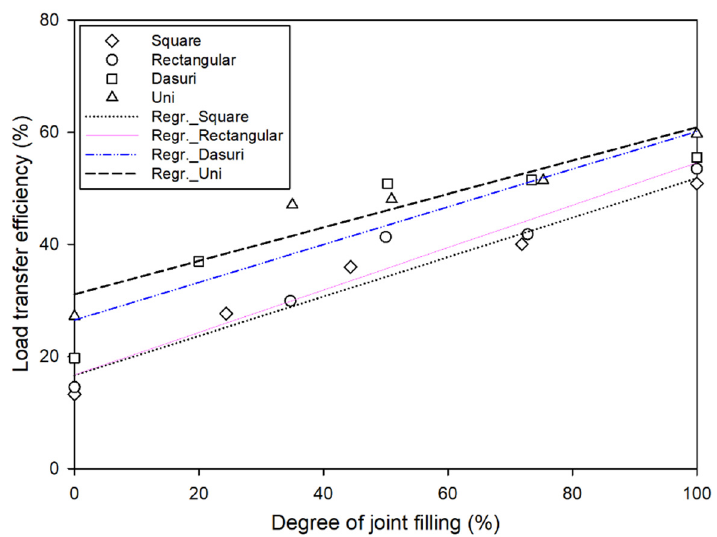
Figure 5. LTEs by block shapes.